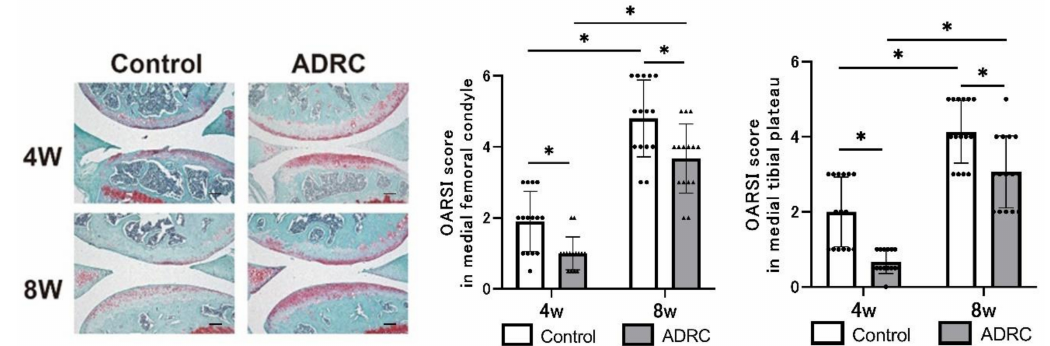
Figure 2. Histological analysis of osteoarthritis progression. Representative images at four and eight weeks after transplan- tation. Images were taken at 200 × . Asterisk indicates statistically significant differences in multiple-comparison testing. Scale bars = 100 µ